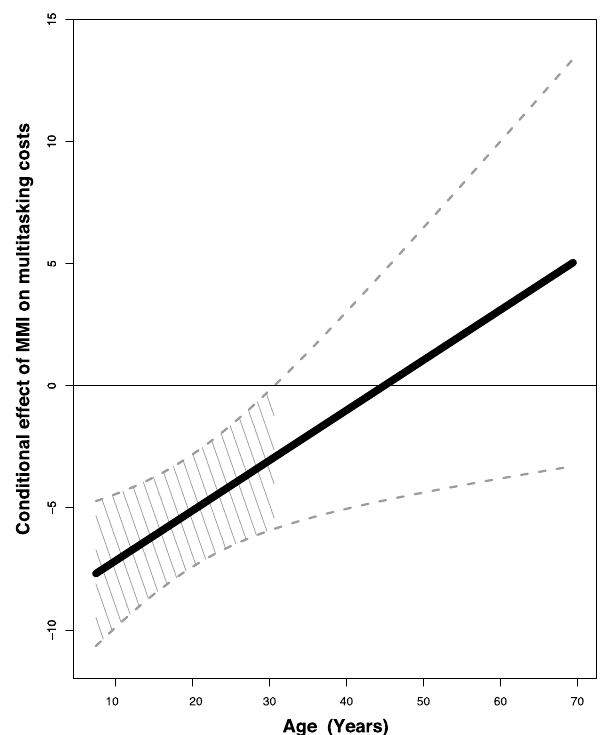
Figure 5. Johnson–Neyman interaction plot for the moderating effect of age on the relationship between MMI and multitasking cost. The Y-axis depicts values for the adjusted effect of MMI on multitasking cost. The bold line represents values of the adjusted effect that correspond to the full range of ages. The dashed lines show the 95% confidence interval around the adjusted effect of MMI on multitasking costs. The shaded area is the Johnson–Neyman significance region, i.e., the period over which the relationship between age and the conditional effect of MMI on multitasking cost is